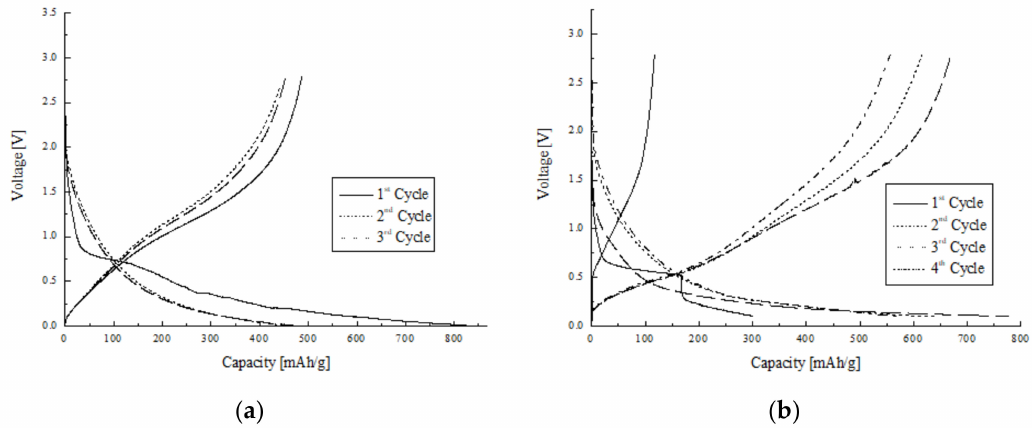
Figure 5. Charging/discharging curves of: ( a ) TEOS Carbon; and ( b ) TEOS/Si Hybrid